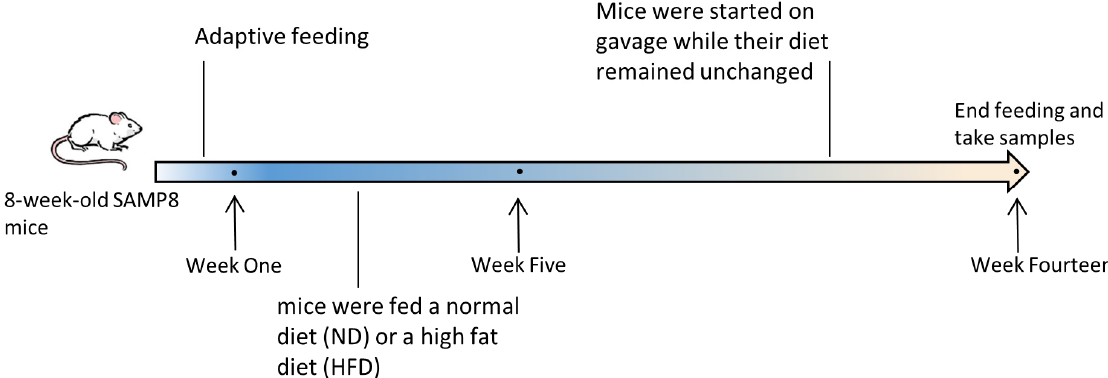
Figure 1. Experimental design in mice.